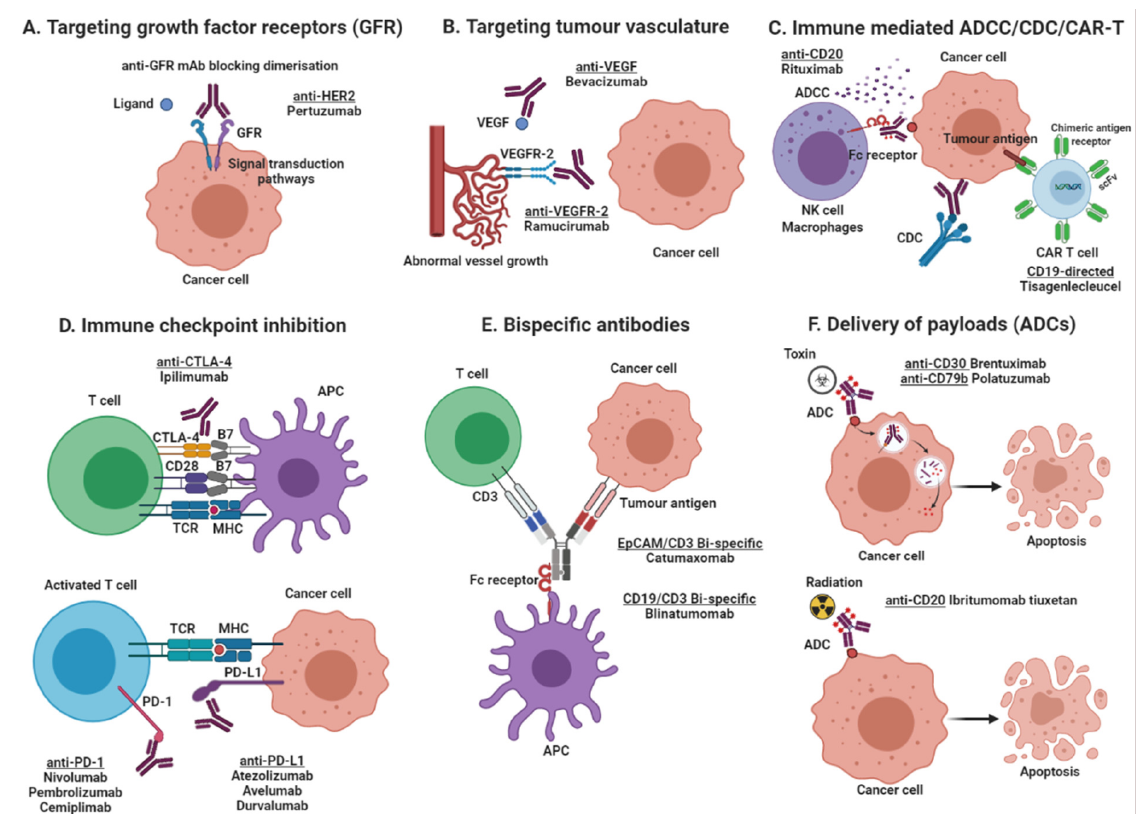
Figure 1. Mechanisms of action of monoclonal antibody-based products. ( A ) Targeting growth factor receptors, blocking the binding of an activating ligand and inhibiting receptor homo- and heterodimerization; ( B ) Targeting of tumour vasculature receptor or its ligands inhibiting angiogenesis; ( C ) Induction of apoptosis by recruitment of immune effector cells (ADCC) or activation of the complement cascade (CDC), and the use of antibody-based molecules to engineer T lymphocytes (CAR T cells); ( D ) Immune checkpoint inhibition by blockade of the PD-1/PD-L1 axis or CTLA-4 inhibitory receptors, increasing cytotoxic T cell activity; ( E ) Simultaneous targeting of two antigens, one on tumour cells and one on effector T cells, by using bispecific antibodies (BITE, bispecific T-cell enhancing); and ( F ) Delivery of payloads such as toxins and radioisotopes to tumour cells. Created with BioRender.com (accessed on 17 March